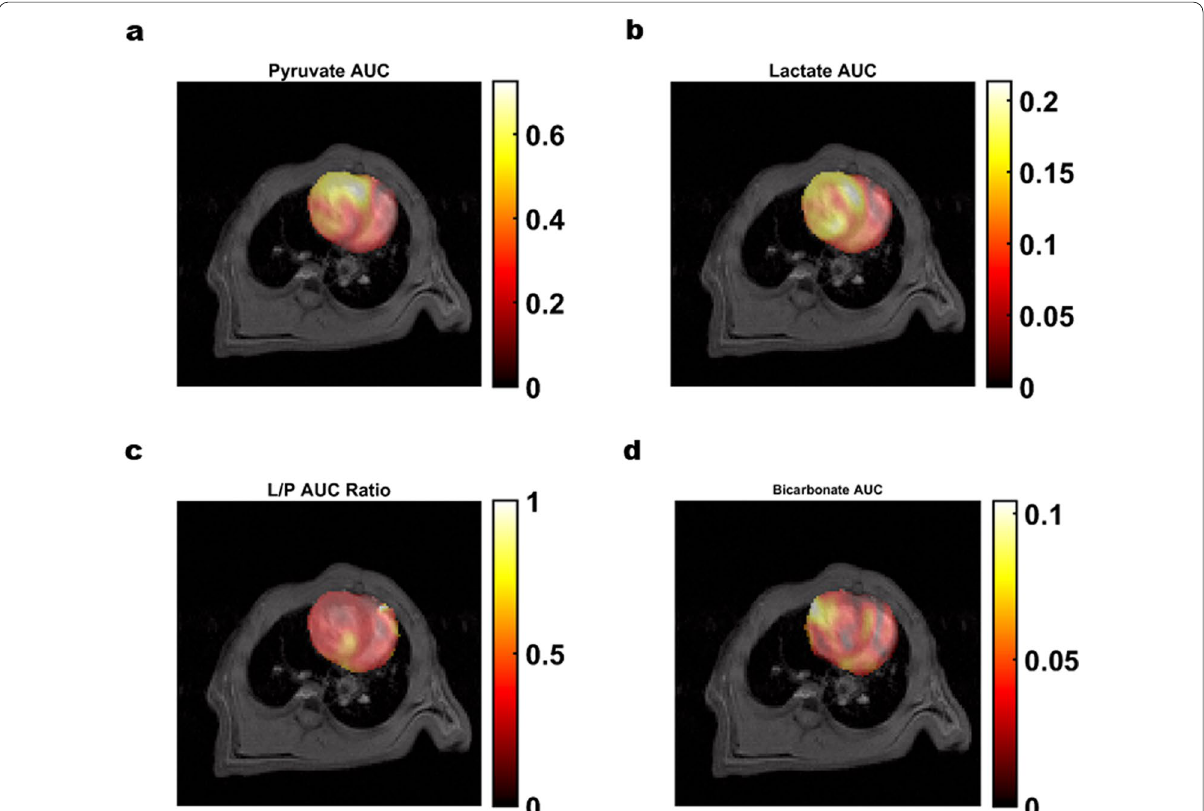
Fig. 10 13 C images of pyruvate ( a ), lactate ( b ), lactate/pyruvate (L/P) area under the curve (AUC) ratio ( c ), and bicarbonate ( d ) in the LV measured using dynamic HP [1-13C]pyruvate MRI. Metabolite images (color) are overlaid on T1-weighted axial images (grayscale) for anatomical reference. Reproduced with permission from Elsevier Ltd (License Number: 5324651196851). Magn Reson Imaging. 2020